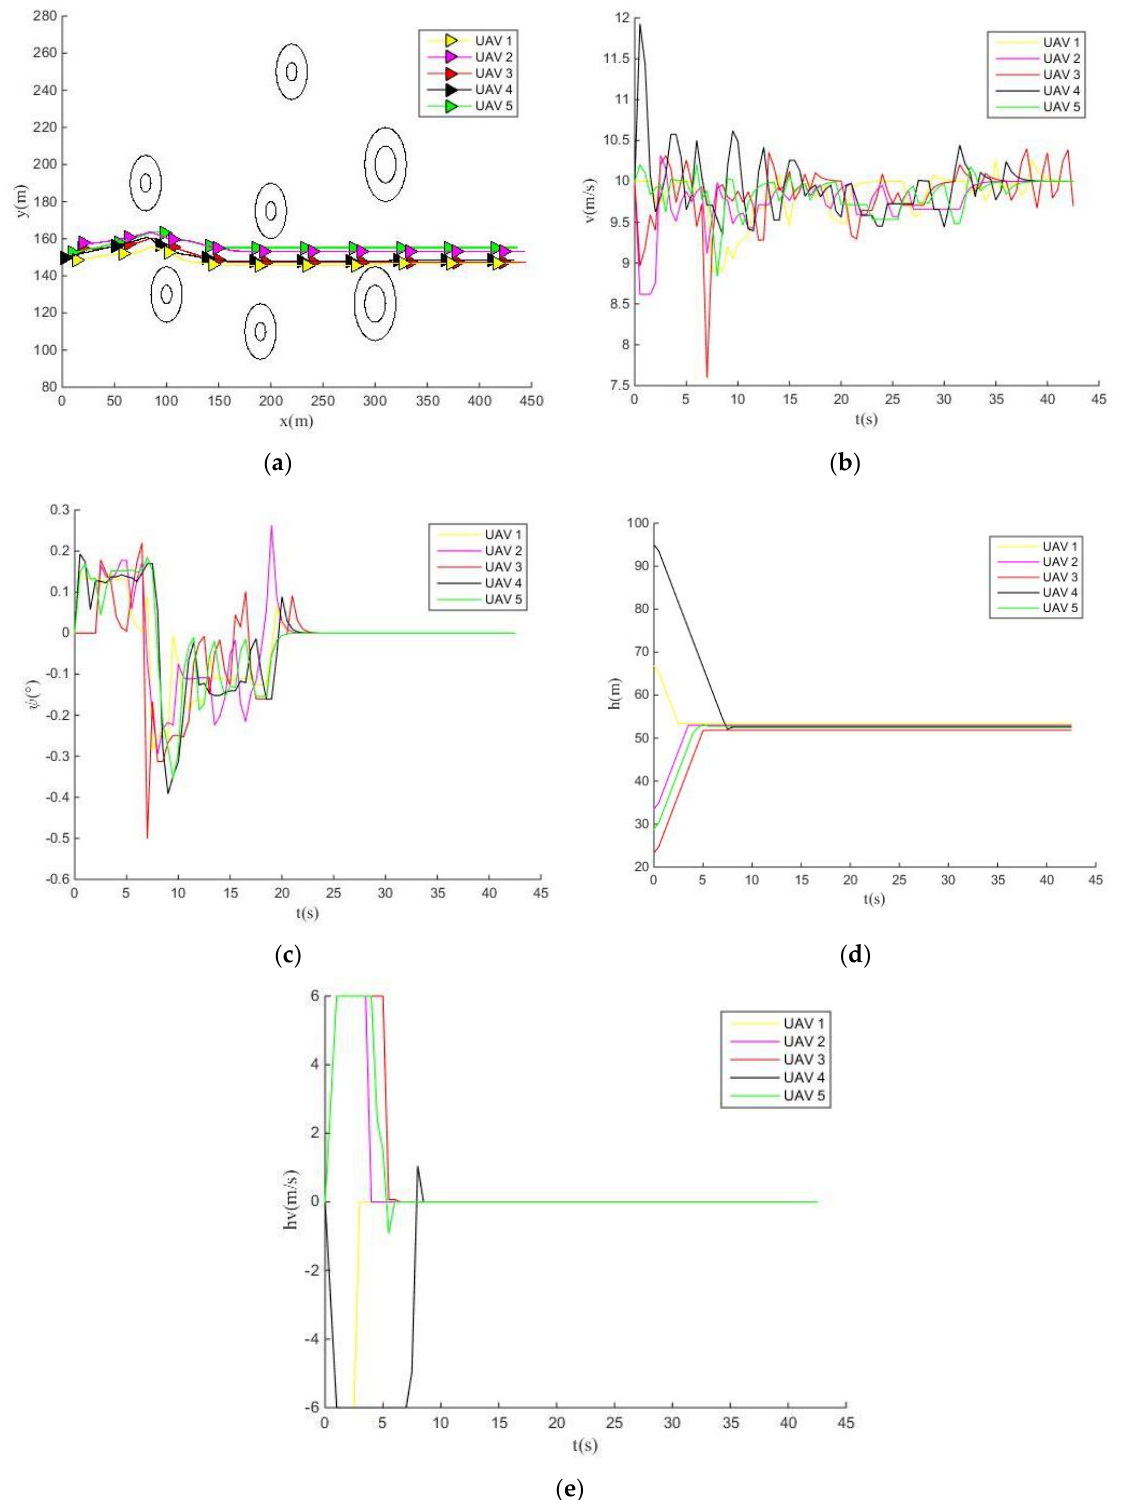
Figure 12. IMOCS optimizes the flight change curves of UAVs. ( a ) Obstacle avoidance curve of UAVs; ( b ) Horizontal airspeed change curves of UAVs; ( c ) Yaw angle change curves of UAVs; ( d ) Flight altitude change curves of UAVs; ( e ) Altitude rate change curves of UAVs.